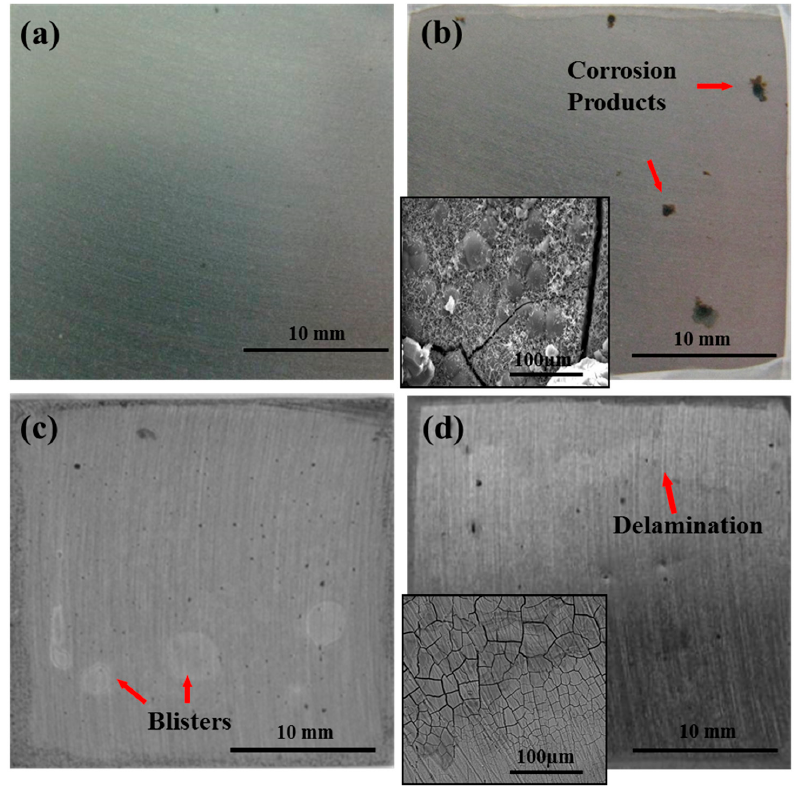
Figure 3. Macroscopic morphology pictures of epoxy glass flake (EGF) coating/steel under different pressure conditions: under ordinary pressure ( a ) after immersion 192 h and ( b ) after 720 h (30 d); under hydrostatic pressure ( c ) after 192 h and ( d ) after 720 h (30 d). The corresponding microscopic corrosion morphologies after 720 h under two conditions are shown in ( b ) and ( d ), respectively.